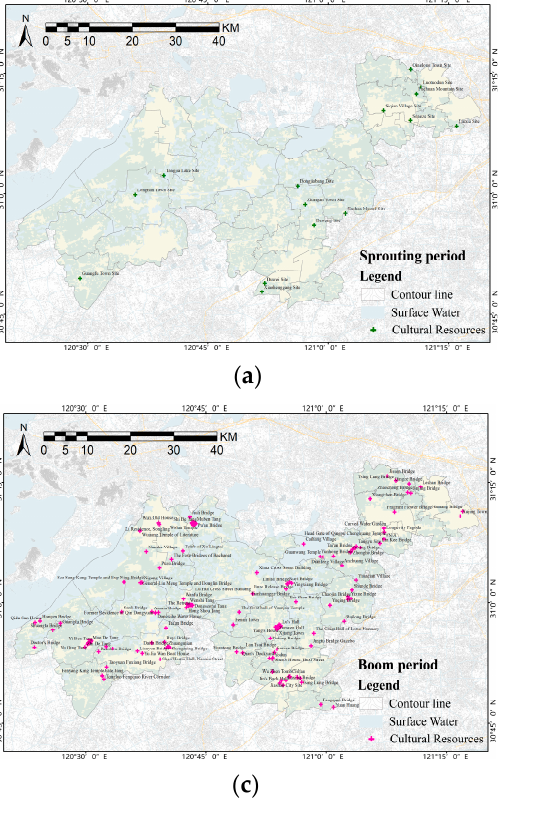
Figure 6. Temporal and spatial distributions of cultural resources in the demonstration area. ( a ) Sprouting period; ( b ) pioneering period; ( c ) boom period; ( d ) transition period. Table 3. Core values of the vernacular cultural landscape in the demonstration